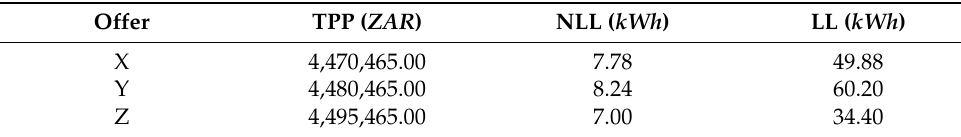
Table 4. Competing transformer manufacturers offer.